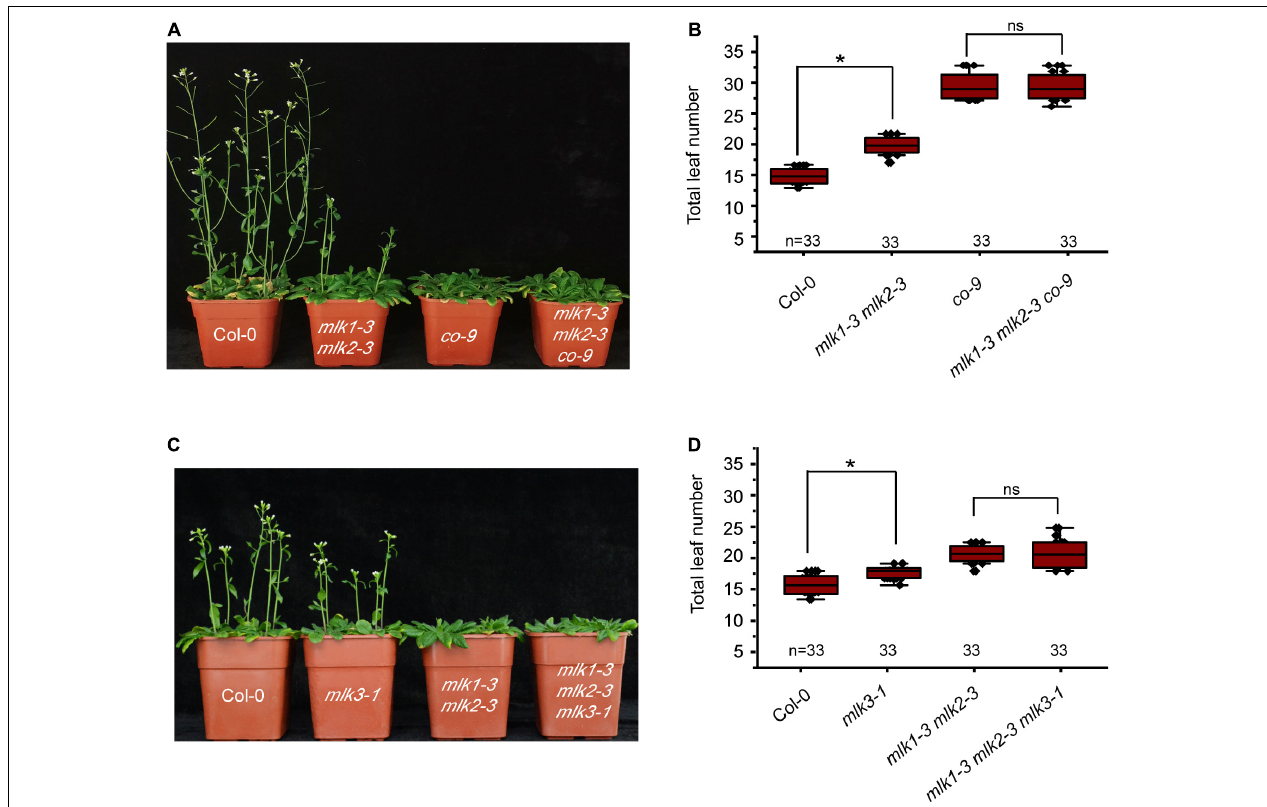
FIGURE 2 | Loss of MLK1 and MLK2 function resulted in late-flowering phenotype. (A) The representative phenotype of Col-0, mlk1-3 mlk2-3 , co-9 , and mlk1-3 mlk2-3 co-9 plants under a LD photoperiod. (B) The total leaf number of Col-0, mlk1-3 mlk2-3 , co-9 , and mlk1-3 mlk2-3 co-9 mutants under a LD photoperiod. Values shown are mean ± SD of total leaves; 33 plants were scored for each line. Asterisks indicate P < 0.05 by t -test, ns indicates no significance. (C) The representative phenotype of Col-0, mlk1-3 mlk2-3 , mlk3-1 , and mlk1-3 mlk2-3 mlk3-1 plants under a LD photoperiod. (D) The total leaf number of Col-0, mlk1 mlk2 , mlk3 , and mlk1 mlk2 mlk3 mutants under a LD photoperiod. Values shown are mean ± SD of total leaves; 33 plants were scored for each line. Asterisks indicate P < 0.05 and ns indicates no significance by t